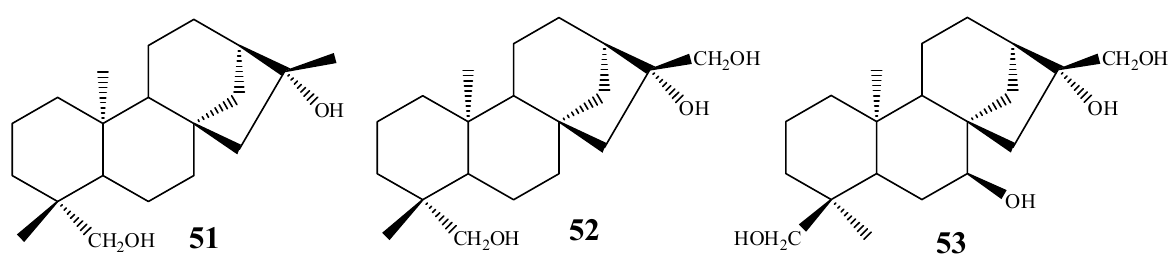
Figure 12. Chemical structures of compounds 51 – 53